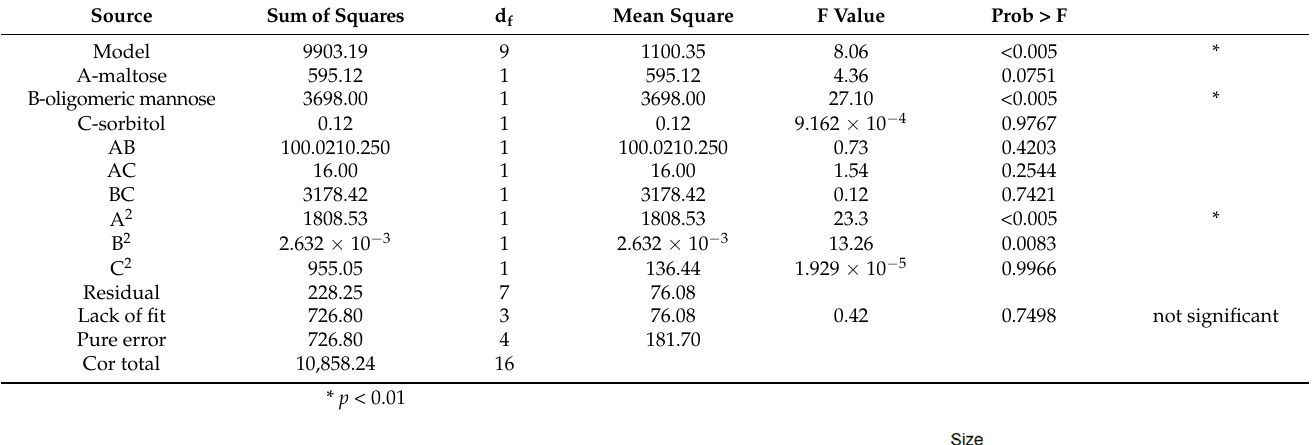
Table 2. ANOVA for response surface quadratic models.